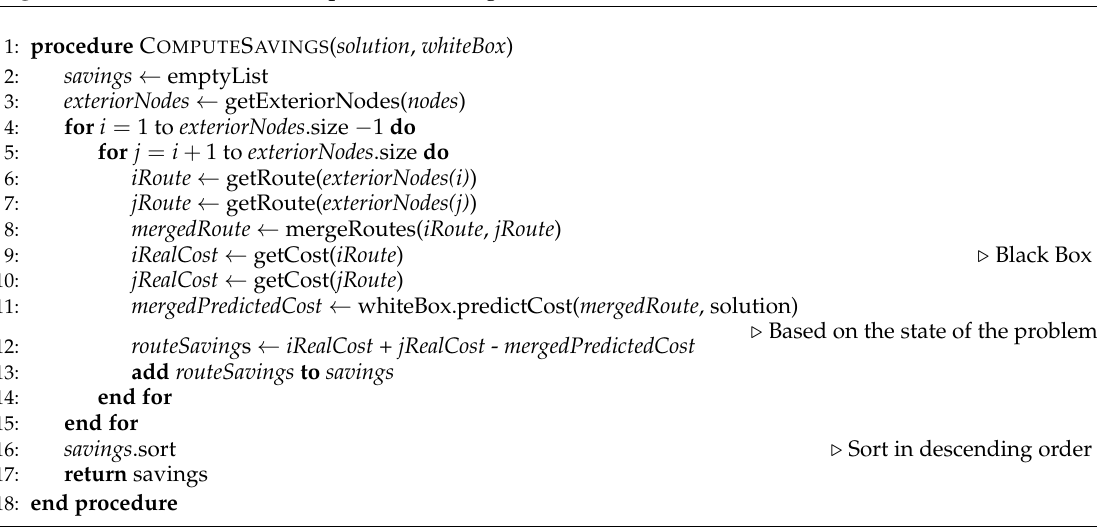
Algorithm 2 Procedure to compute the savings